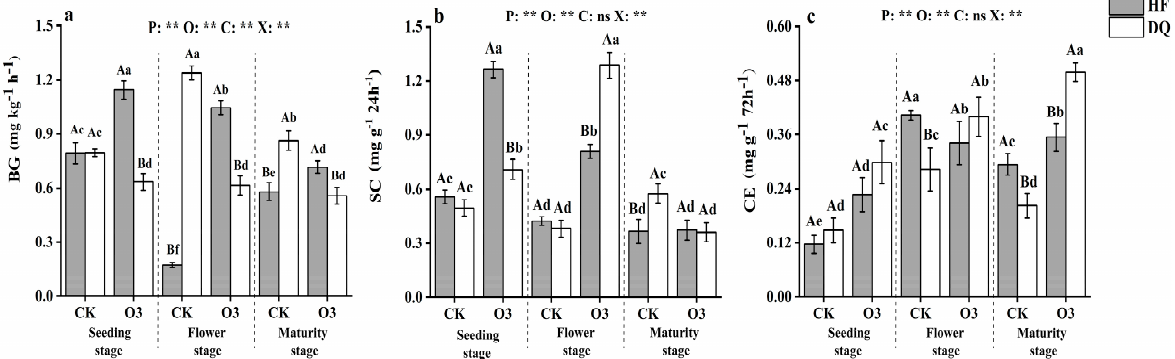
Figure 1. The activity of soil water content (SWC), pH, and soil organic carbon (SOC) in the rhi- zosphere soil of DQ and HF tartary buckwheat at seedling ( a ), flowering ( b ), and maturity stages ( c ). DQ represents low soil nutrient tolerant variety and HF represents low soil nutrient sensitive variety. Bars with different letters indicate a significant difference in the least significant difference (LSD) tests ( p < 0.05) between different cultivars (capital letters) and treatments (small letters). P means treatment period, O means treatment effect, C means cultivar effect, and X means interactive effects of treatment, period, and cultivar. CK, Controlled experiment. O3, Ozone sterilization treat- ment. ** indicates a significant difference ( p < 0.01), and ns indicates no significant difference ( p > 0.05).